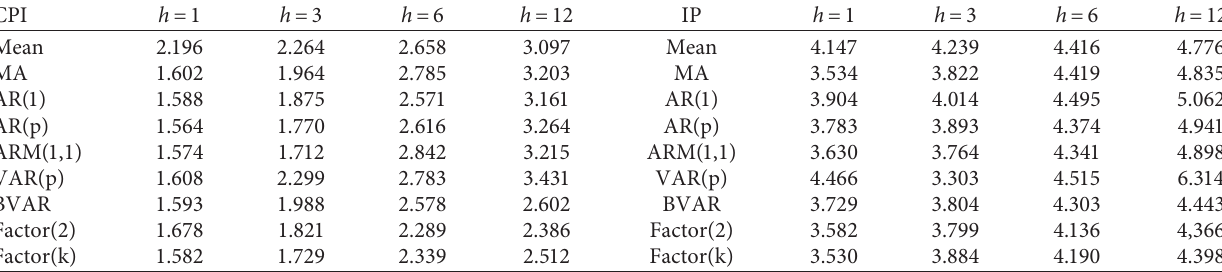
Table 1: RMSE value of CPI and industrial value added forecast in China.